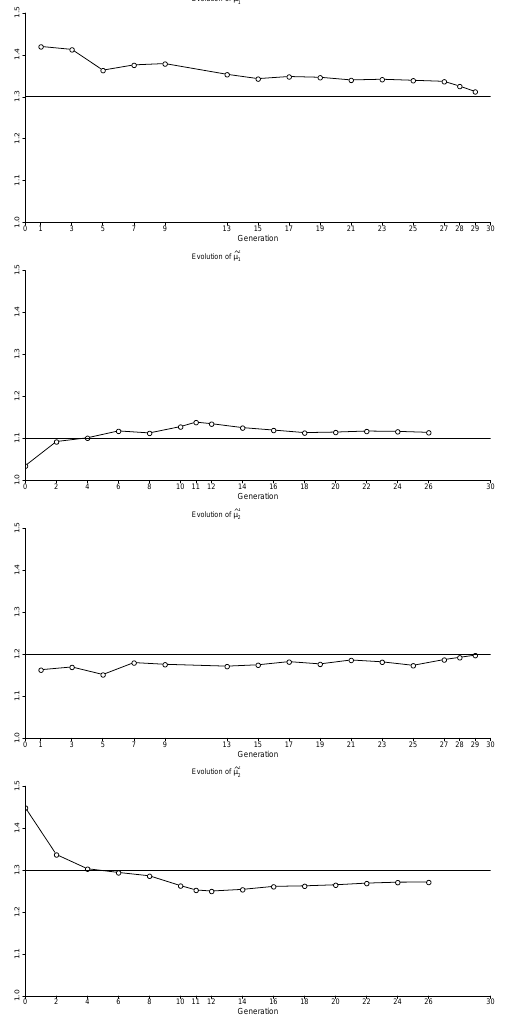
Figure 3. Evolution of the estimates (cid:99) µ 1 and T ∗ , 2